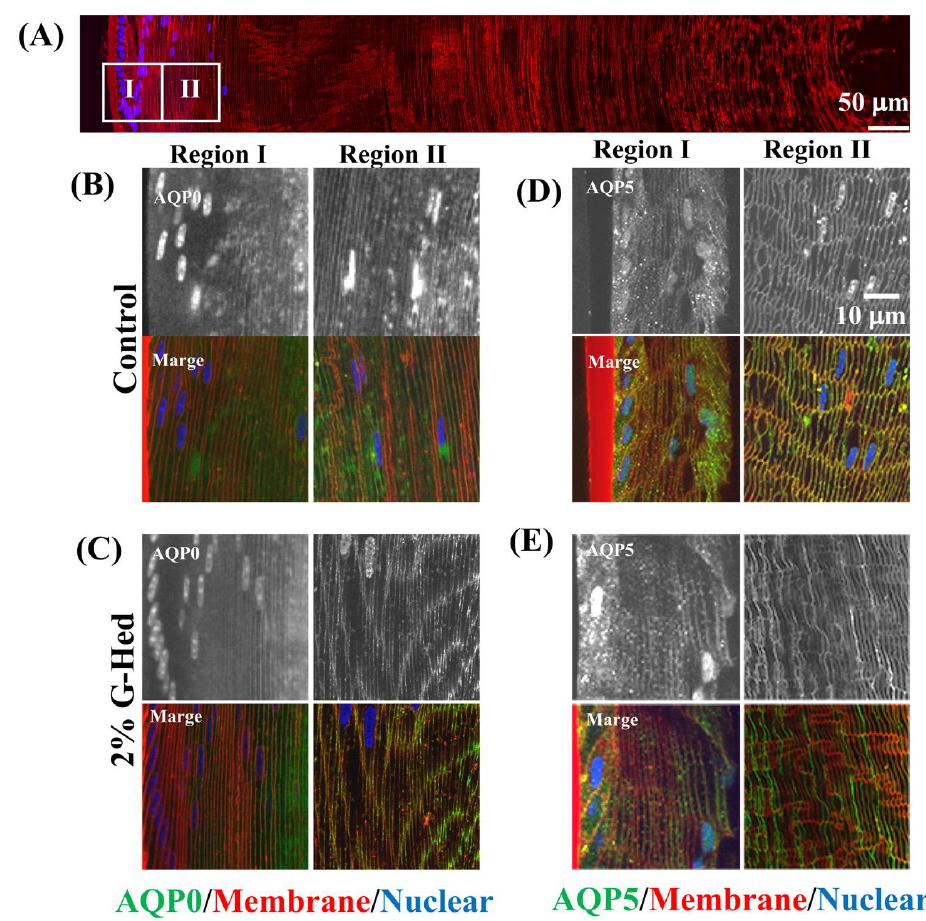
Figure 4. Effect for subcellular distribution of Aquaporins in the lens. After LT administration with 2% G-Hsd solution, subcellular localization of AQP0 and AQP5 in the peripheral regions of the lens was imaged using confocal microscopy. ( A ) A montage of images collected from the lens equator to the core. High power images from the outer 2 regions (boxes) were obtained. ( B , C ) High power images of sections labeled with AQP0 from ( B ) control mice lens and ( C ) 2% G-Hsd for 49-week exposed mice lens. Upper panels were images of AQP0 signal alone, and lower panels were merged images with AQP0, WGA (membrane), and DAPI (nuclear). ( D , E ) High power images of sections labeled with AQP5 from ( D ) control mice lens and ( E ) 2% G-Hsd for 49-week exposed mice lens. Upper panels were images of AQP5 signal alone, and lower panels were merged images with AQP5, WGA 5, and DAPI. The experiments used three to five independent samples per group.